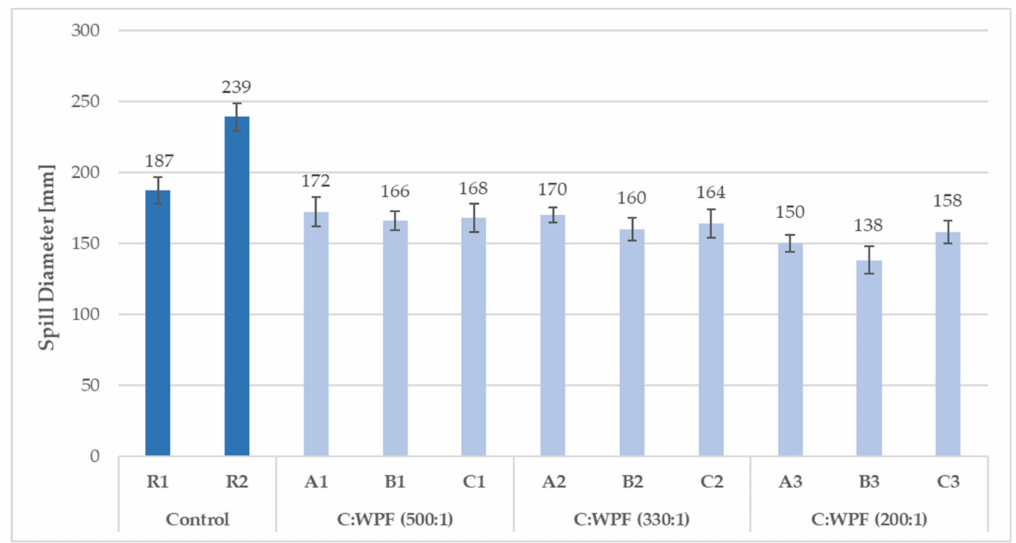
Figure 4. Mean spill diameter values for reference and fiber-cement fresh mixtures based on WPF samples (A, B, and C) with different C/WPF ratios (set